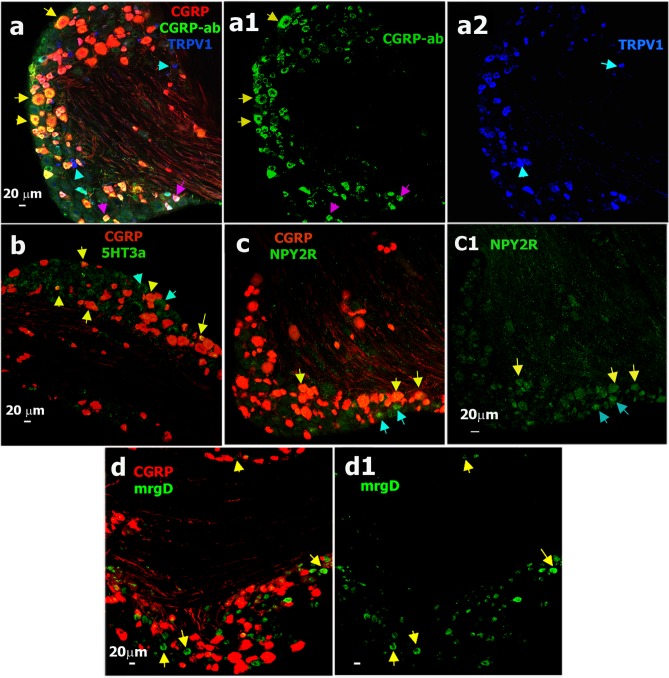
Sensory neuronal markers expressing in CGRP-cre+ DRG neurons.a. Expression of CGRP-ab (green) and TRPV1 (blue) relatively CGRP-cre+ neurons (red) in DRG from CGRPcre-ER/+;Rosa26LSL-tDTomato/+ mice. Medium-large CGRP-cre+/CGRP-ab+ neurons are marked with yellow arrows (a and a1); small CGRP-cre+/CGRP-ab+ neurons are marked with purple arrows (a and a1); and small CGRP-/TRPV1+ neurons (<20μm) are marked with sapphire arrows (a and a2). b. Expression of 5HT3a (green) relative to CGRP-cre+ neurons (red) in DRG. CGRP-cre+/5HT3a+ neurons are marked with yellow arrows and CGRP-cre-/5HT3a+ neurons are marked with sapphire arrows. c. Expression of NPY2R (green) relative to CGRP-cre+ neurons (red) in DRG. Medium NPY2R+/CGRP-cre+ neurons are marked with yellow arrows (c and c1) and medium NPY2R+/CGRP-cre- neurons are marked with sapphire arrows (c and c1). d. Expression of mrgD (green) relative to CGRP-cre+ DRG neurons (red). Yellow arrows mark CGRP-cre-/mrgD+ neurons (d and d1). White horizontal bar shows 20μm scale for each panel.